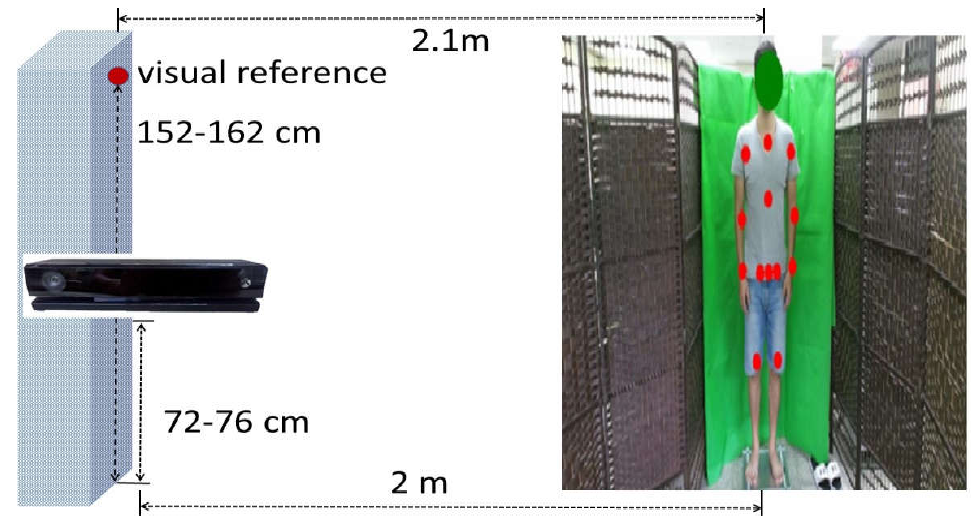
Figure 2. E xperimental setup. Figure 2. Experimental